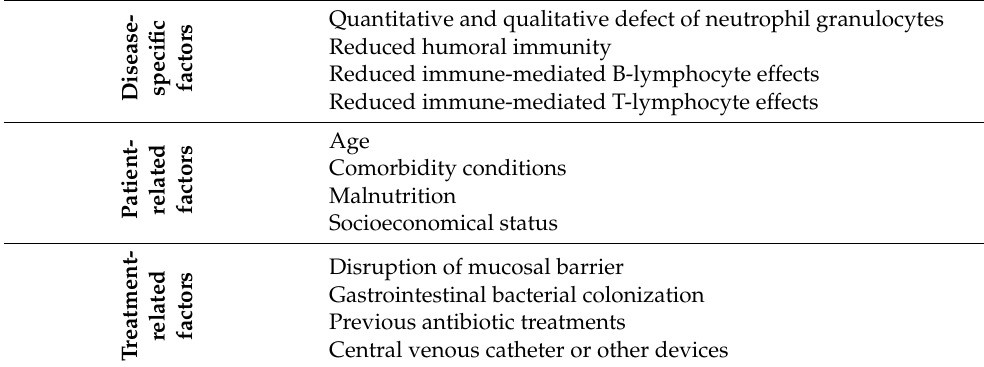
Table 1. Infectious risk in acute leukemia patients. Main factors are related to infection risk in leukemia